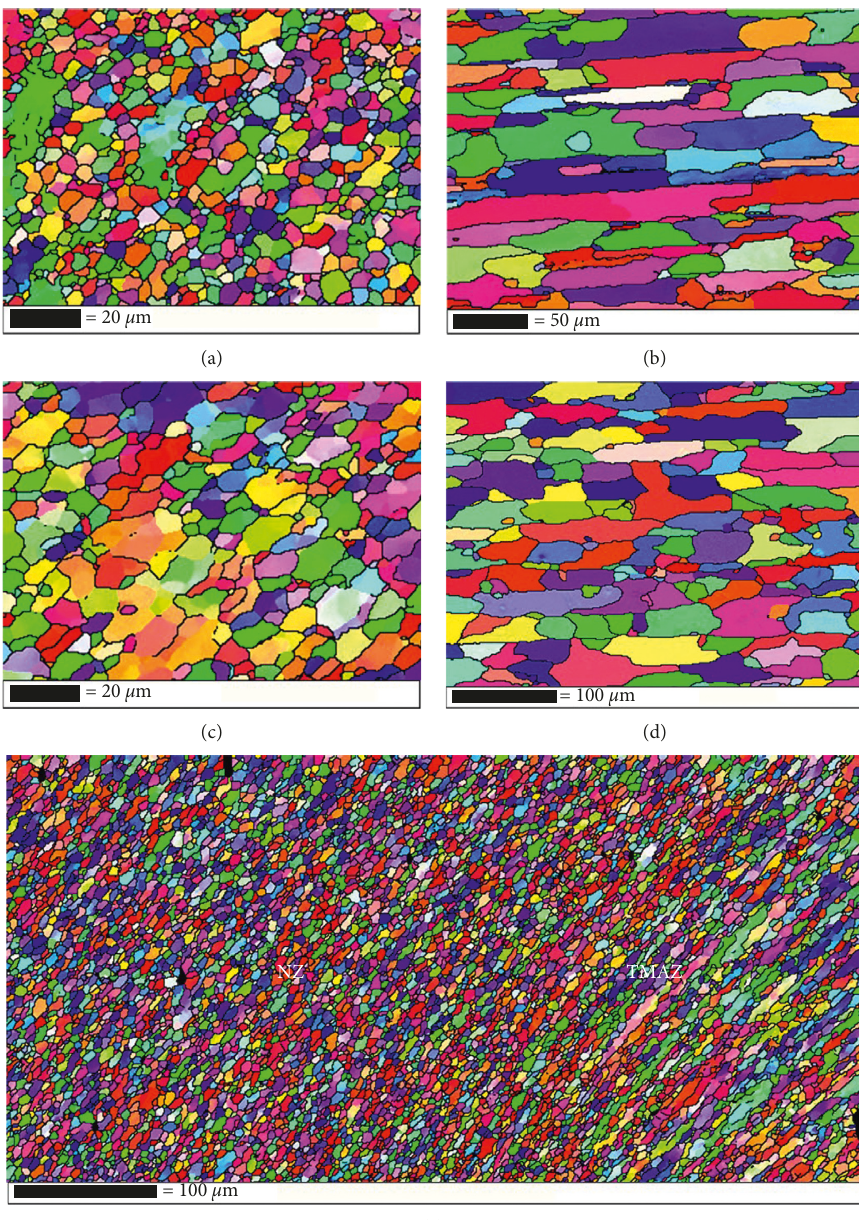
Figure 7: EBSD grain maps of FSW AA 6061-AA 5A06: (a) 5A06 NZ; (b) 5A06 BM; (c) 6061 NZ; (d) 6061 BM; (e) 6061